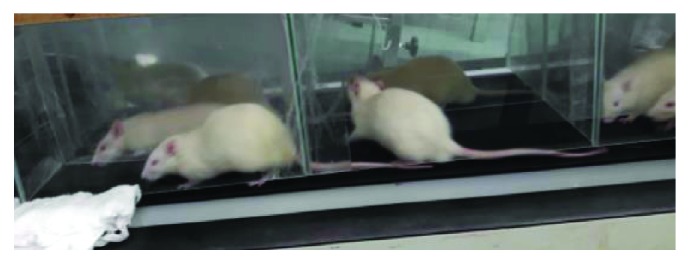
Animals performing eccentric training.